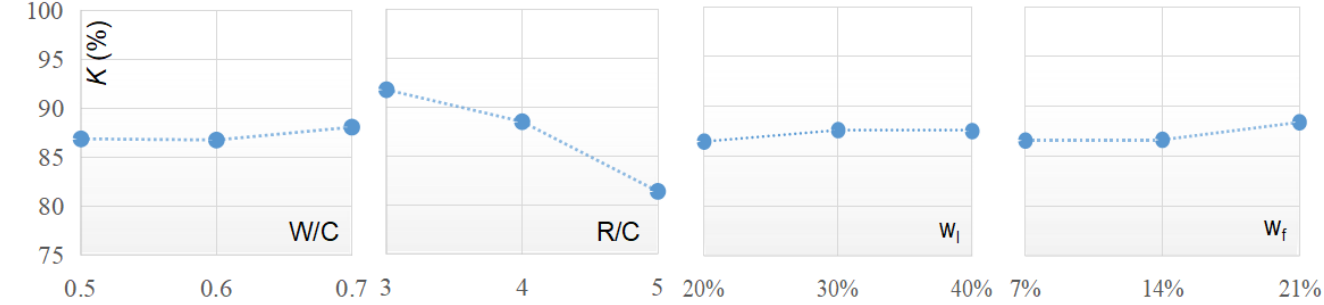
Figure 8. Intuitive analysis of the water absorption of four factors.